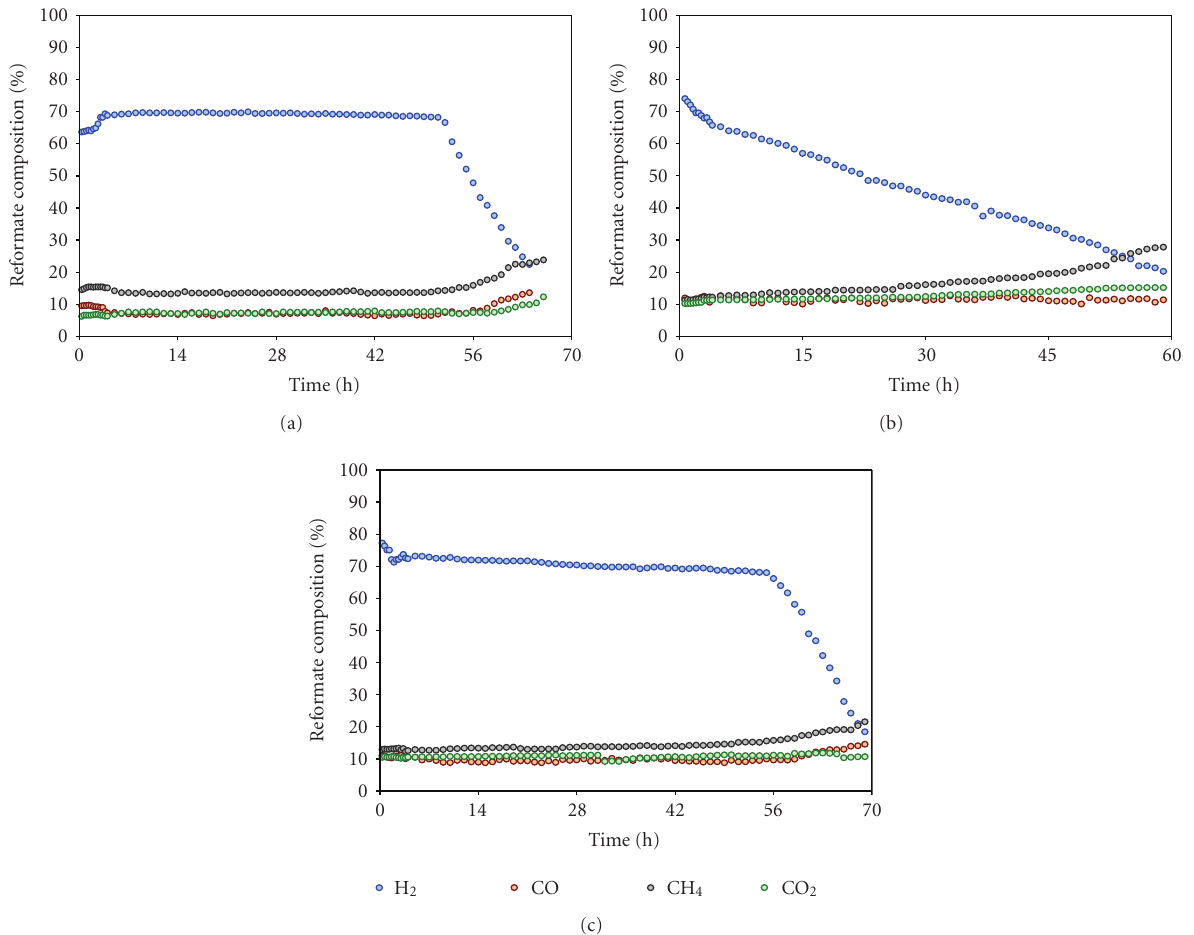
as presumed in the thermodynamic calculations by the simulation